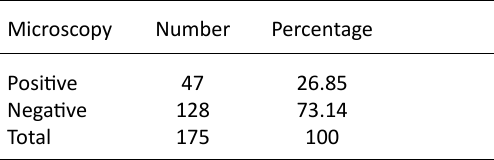
Table 4. Findings of Culture for Symptomatic Pregnant